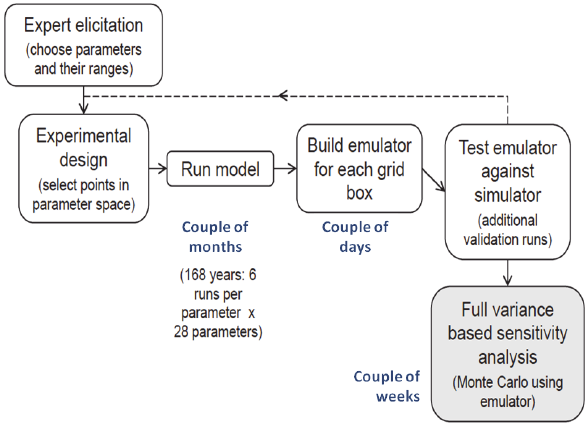
Fig. 1. The step-by-step approach to sensitivity analysis via emulation. The blue text indicates the approximate computation time.